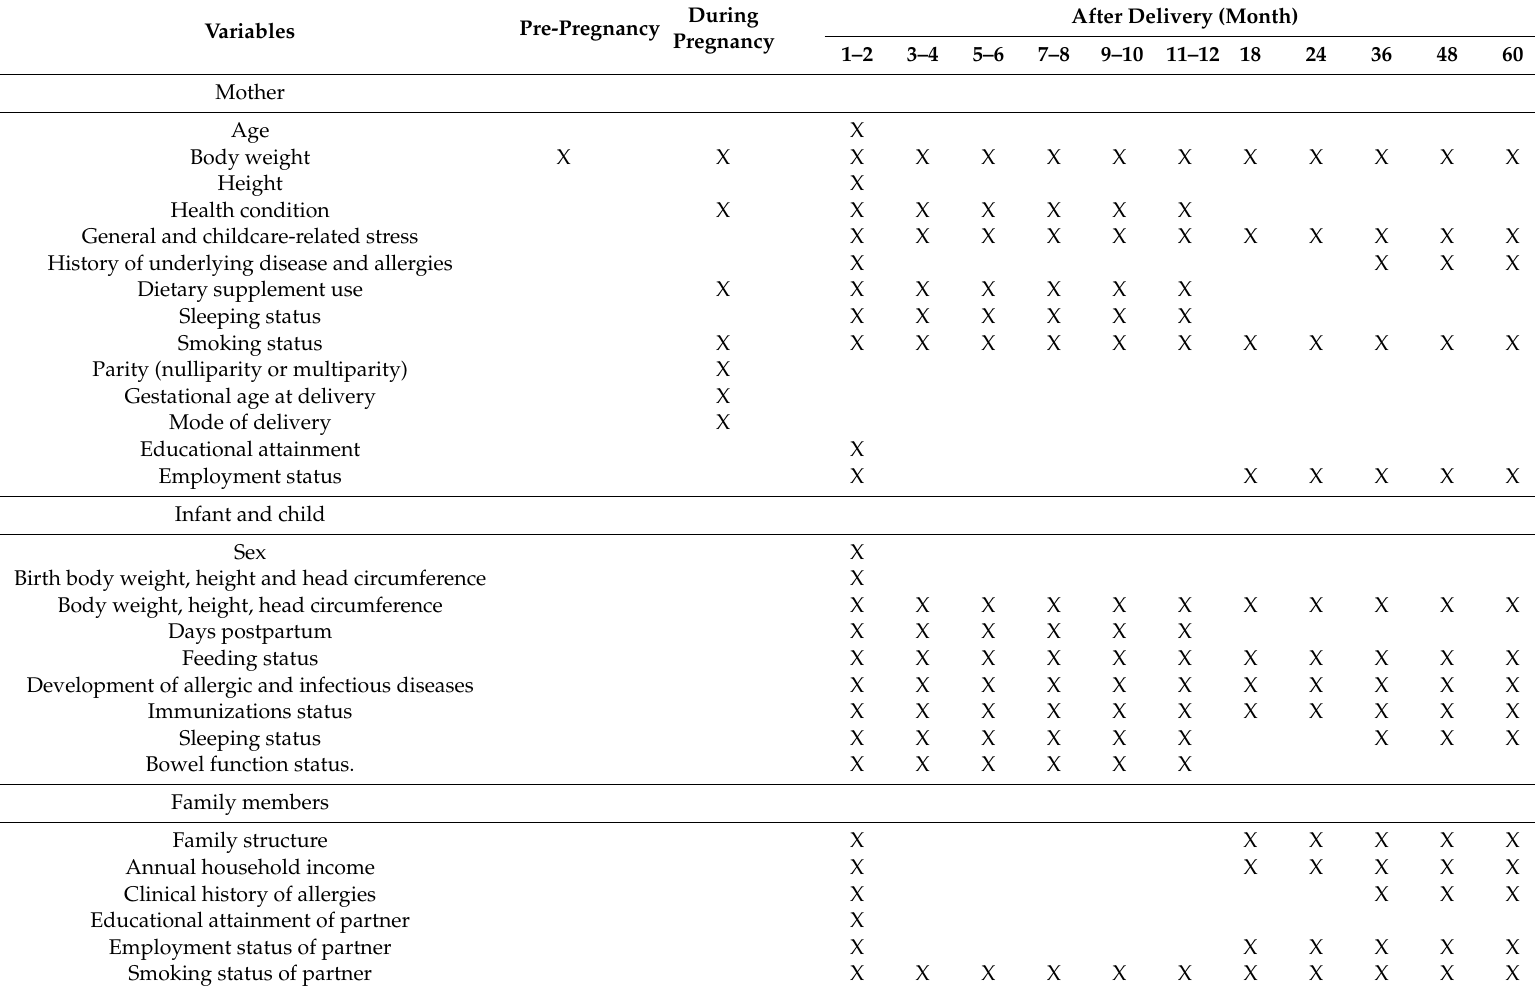
Table 1. Summary of data collection for health information